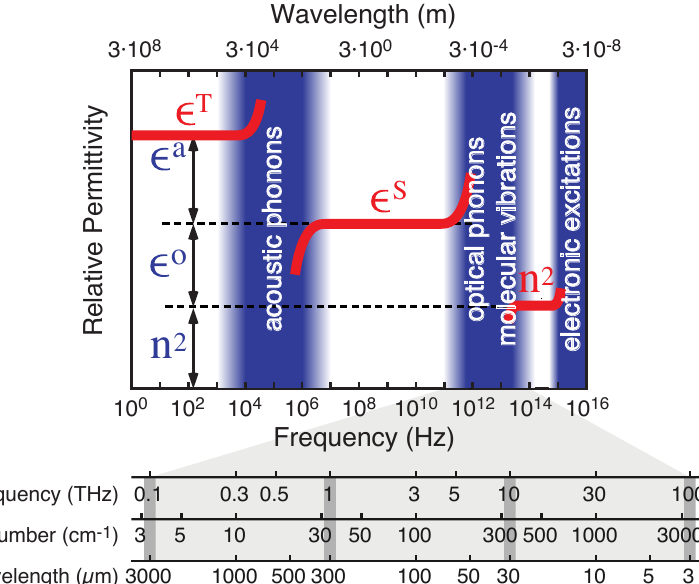
Figure 3. Schematics of the material linear polarization response as a function of frequency of the external electric field. For organic materials, the contributions of (cid:101) o and (cid:101) a to the static relative permittivity (cid:101) T are much less important compared to inorganic materials, which is an important advantage for high-speed electro-optic modulation and THz-photonics applications (see text). The scale below shows the THz frequency range in frequency f , wavelength λ , and spectroscopic wavenumber 1/ λ